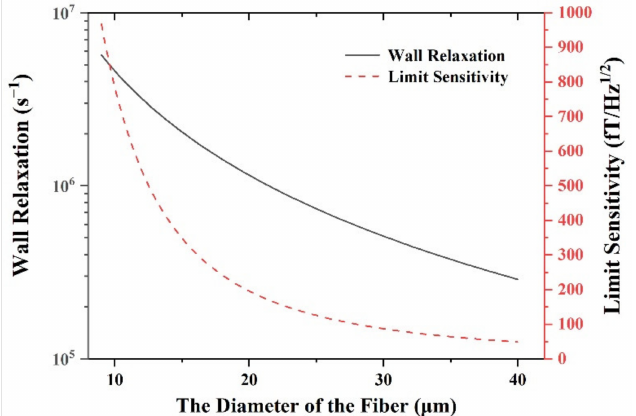
Figure 2. The relaxation of wall collision with the diameter of the fiber. The black solid line indicates the wall relaxation of the fiber cell. The wall relaxation rates decrease rapidly from 5.69 × 10 6 s − 1 to 2.88 × 10 5 s − 1 with the increase in fiber core diameter from 4.5 µ m to 40 µ m. The red line in Figure 2 shows that the limit sensitivity for SERF AM increases from 967 fT/Hz 1/2 to 48.2 fT/Hz 1/2 , corresponding to the wall relaxation rates. Compared with the relaxation rates of other regimes, the wall relaxation is the major one, which determines the limit sensitivity of the AM according to Equation